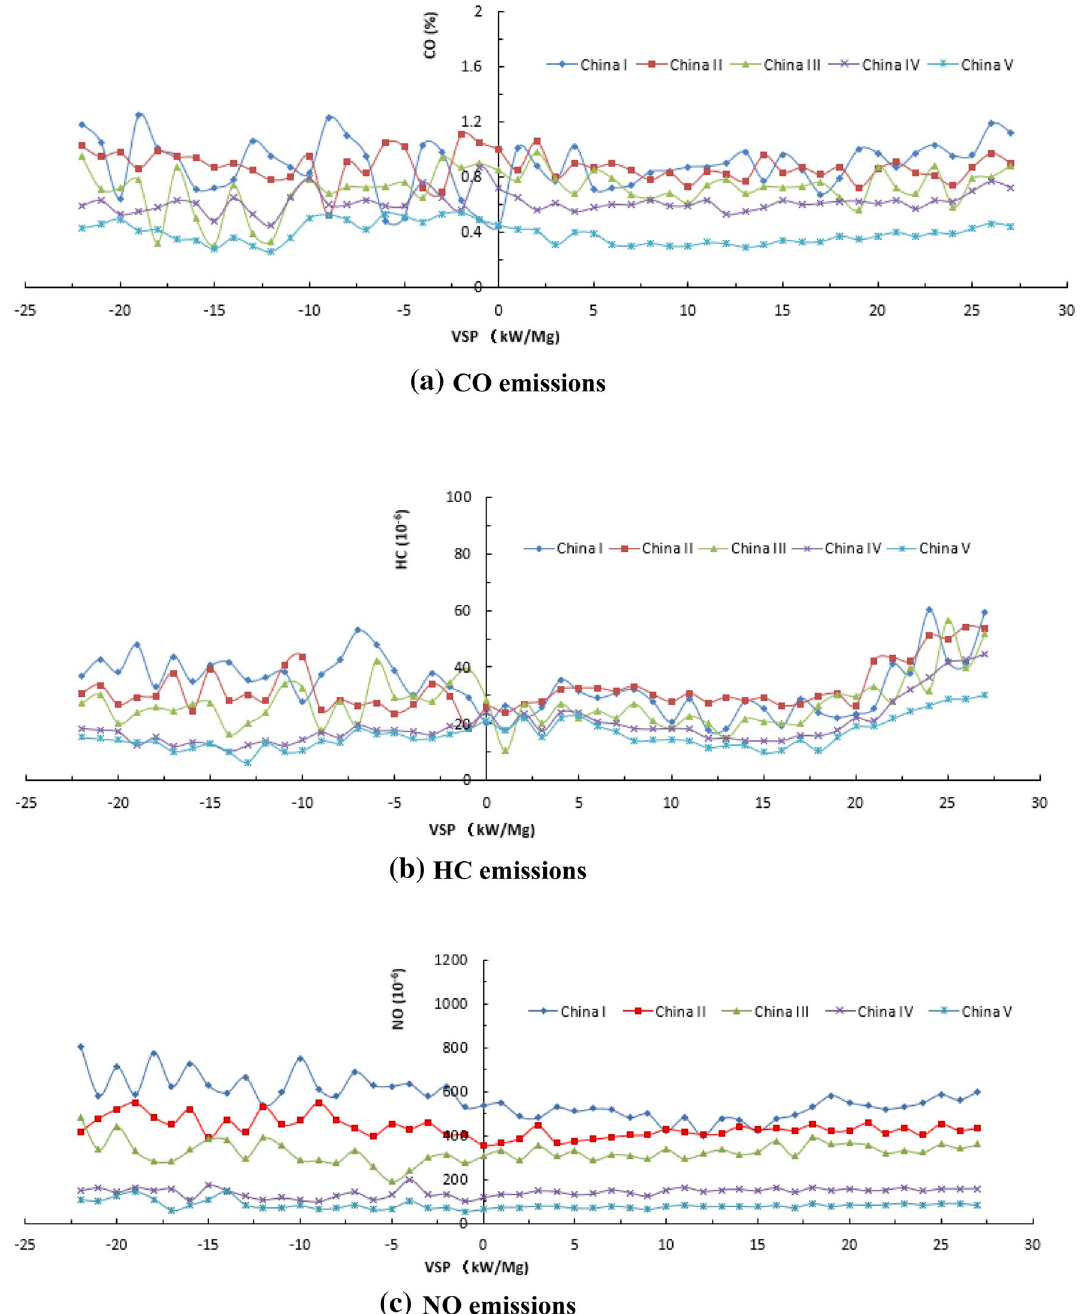
Figure 1. The relationship between the RS emissions and VSP of light-duty gasoline